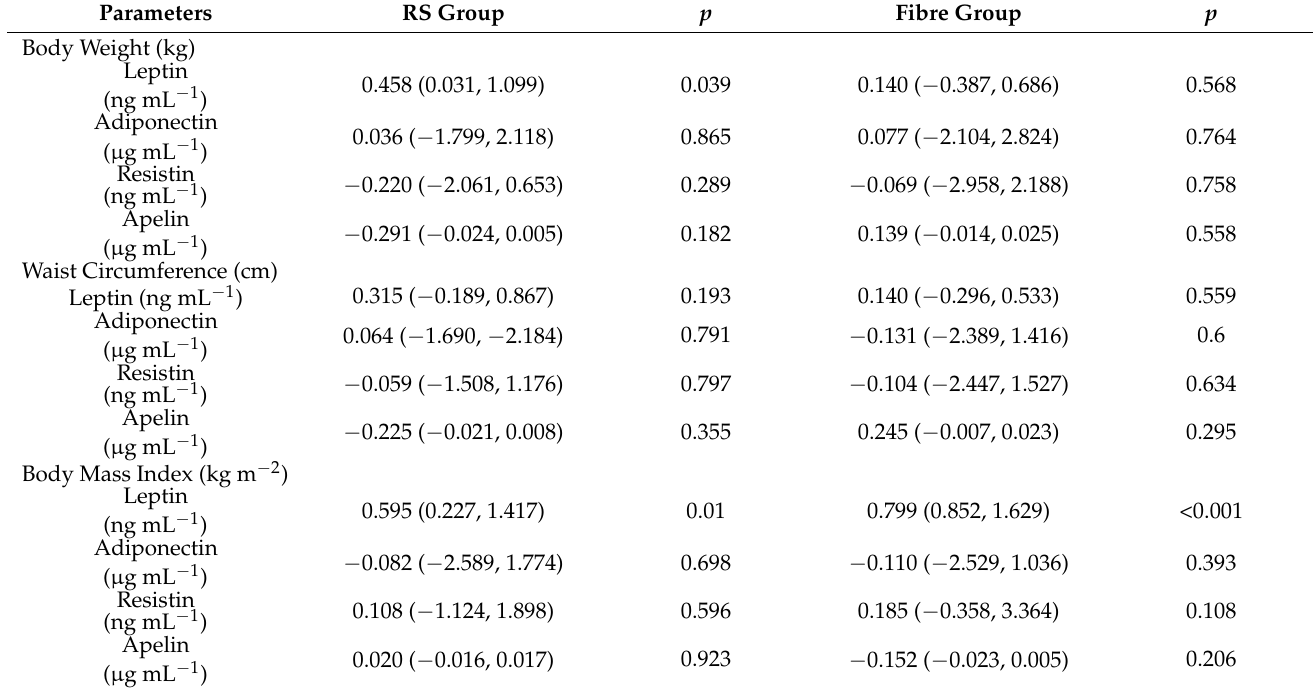
Table 3. Associations between anthrophometric parameters and adipokine levels in the resistant starch (RS) and the Fibre group at the end of the